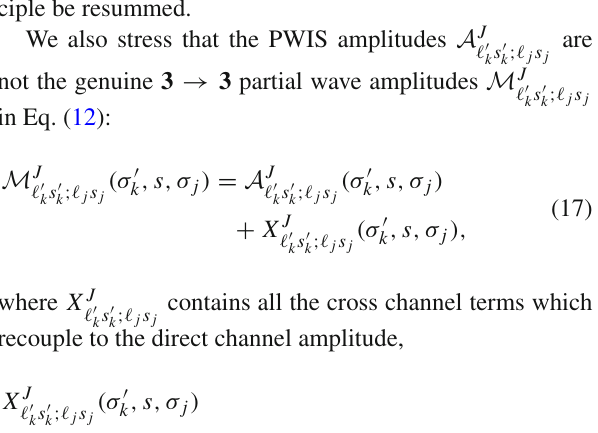
that, while truncation in s (cid:6) and s j cannot be avoided in prac- k tice, unitarity is diagonal in the total angular